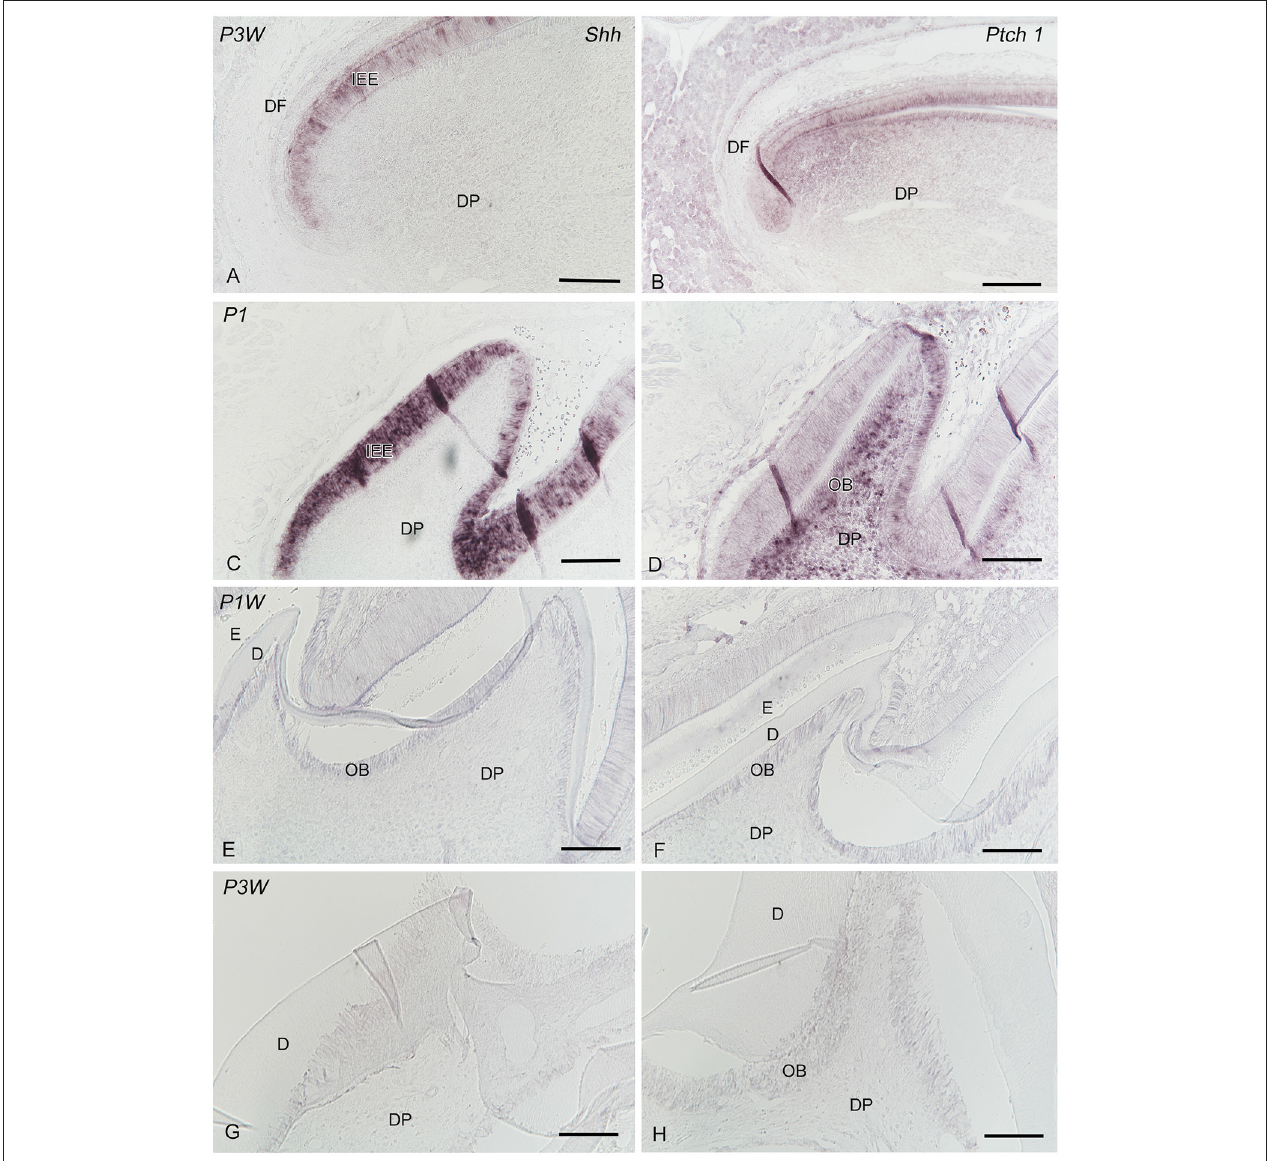
FIGURE 7 | In situ hybridization of Shh (A,C,E,G) and Ptch1 (B,D,F,H) in the incisors (A,B) and developing molars (C–H) at P1 (C,D) , P1W (E,F) , and P3W (G,H) ( D dentin, DP dental papilla or papilla, DF dental follicle, E enamel or enamel space, IEE inner enamel epithelium, OB odontoblasts). (A) Shh is intensely expressed in the inner enamel epithelium. (B) The epithelial and mesenchymal tissues demonstrate Ptch1 expression. (C) Shh is exclusively expressed in the inner enamel epithelium. (E,G) Shh expression in the ameloblasts decreases in intensity, whereas the odontoblasts and the other pulp cells begin to express Shh during P1W-P3W. (D) Ptch1 expression is observed in the inner enamel epithelium and the dental pulp, including odontoblasts (F,H) Ptch1 expression decreases in intensity during P1W–P3W. Scale bars: 100 µ